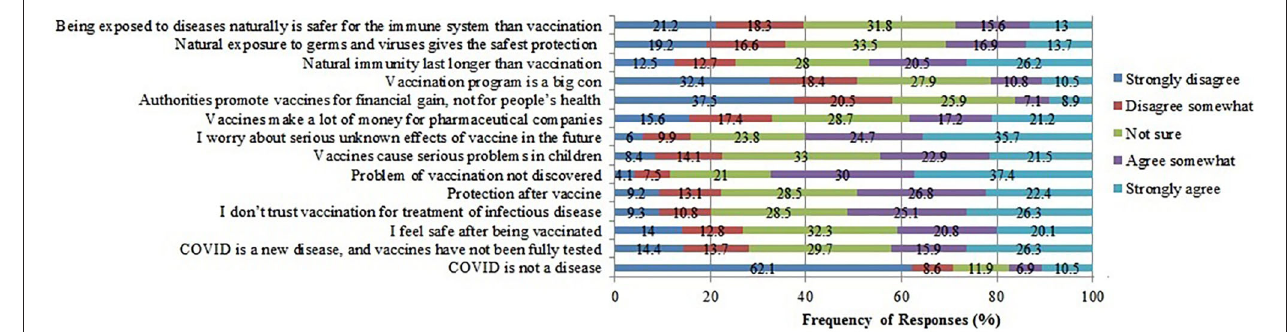
FIGURE 1 | Beliefs toward COVID-19 vaccine and